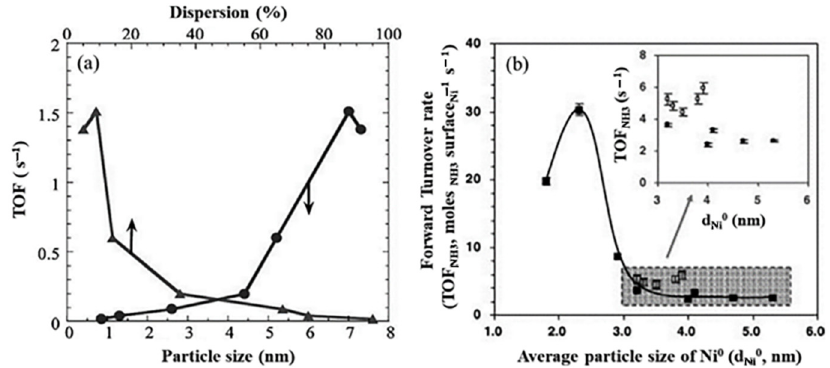
Figure 37. Relationship between the forward ammonia turnover rate (TOF) and average particle size ( a )) for Ni (circles) in compare with Ru (triangles), ( b ) for Ni–Al 2 O 3 (solid squares) in compare with La–Al 2 O 3 catalysts (hollow squares). Reprinted with permission [86].